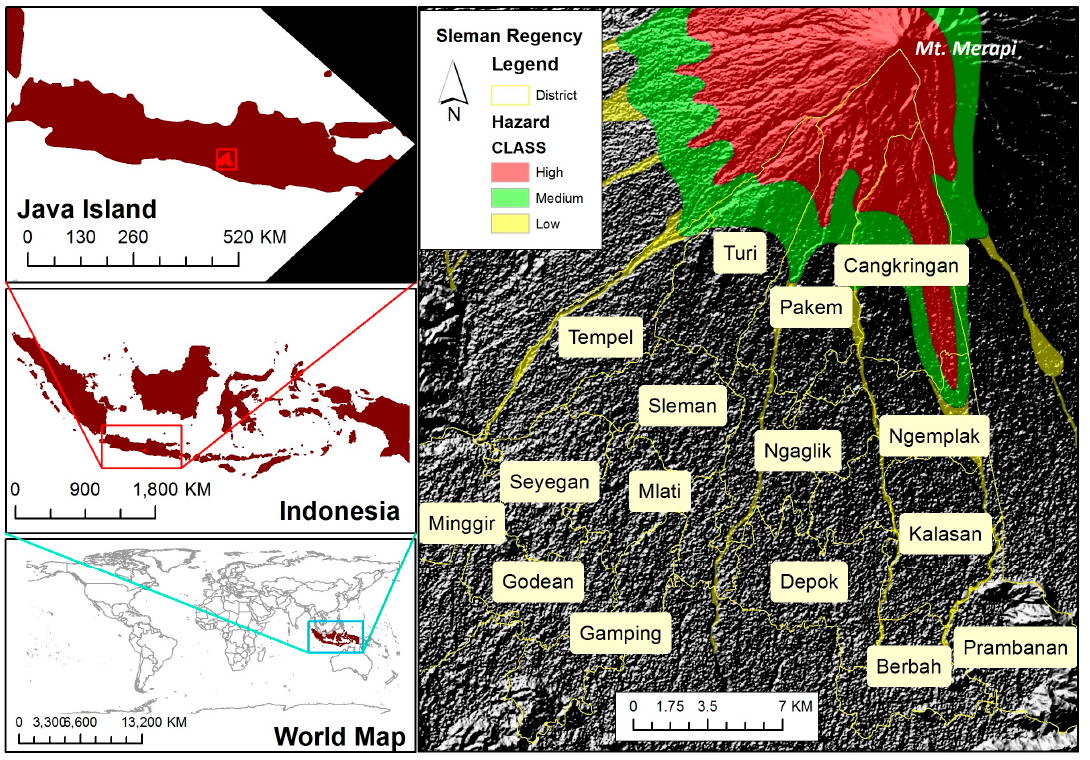
Figure 1. Study area and hazard zones.